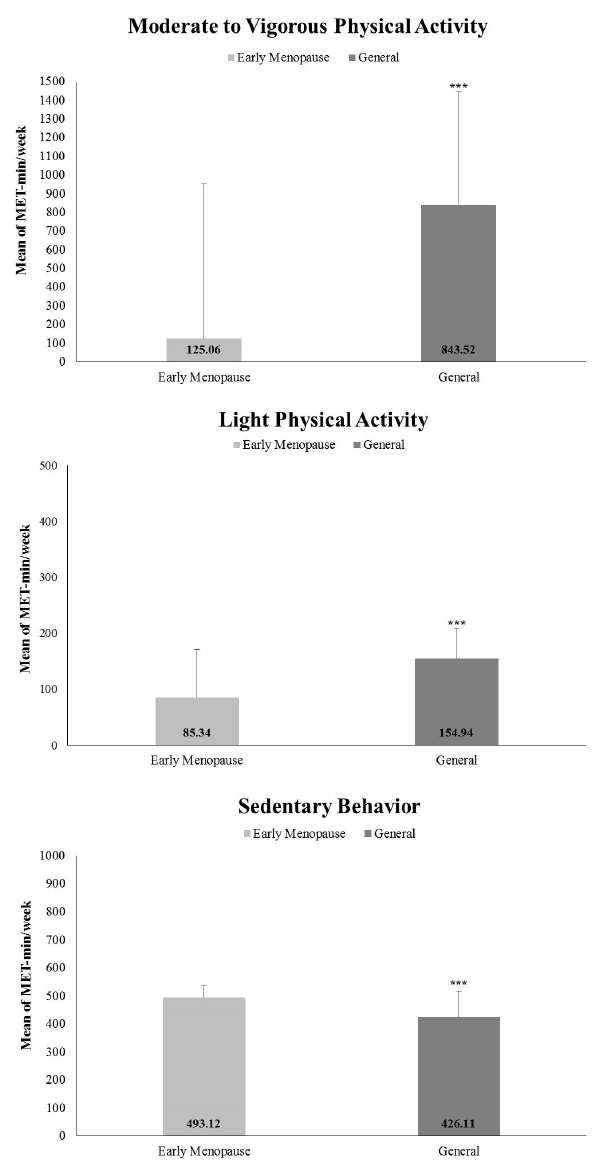
Figure 1. Comparison of average physical activity time and sedentary behavior during a week between early menopausal and general group. The significant differences between the two groups; *** p < 0.001, error bars represent the 95% confidence interval.